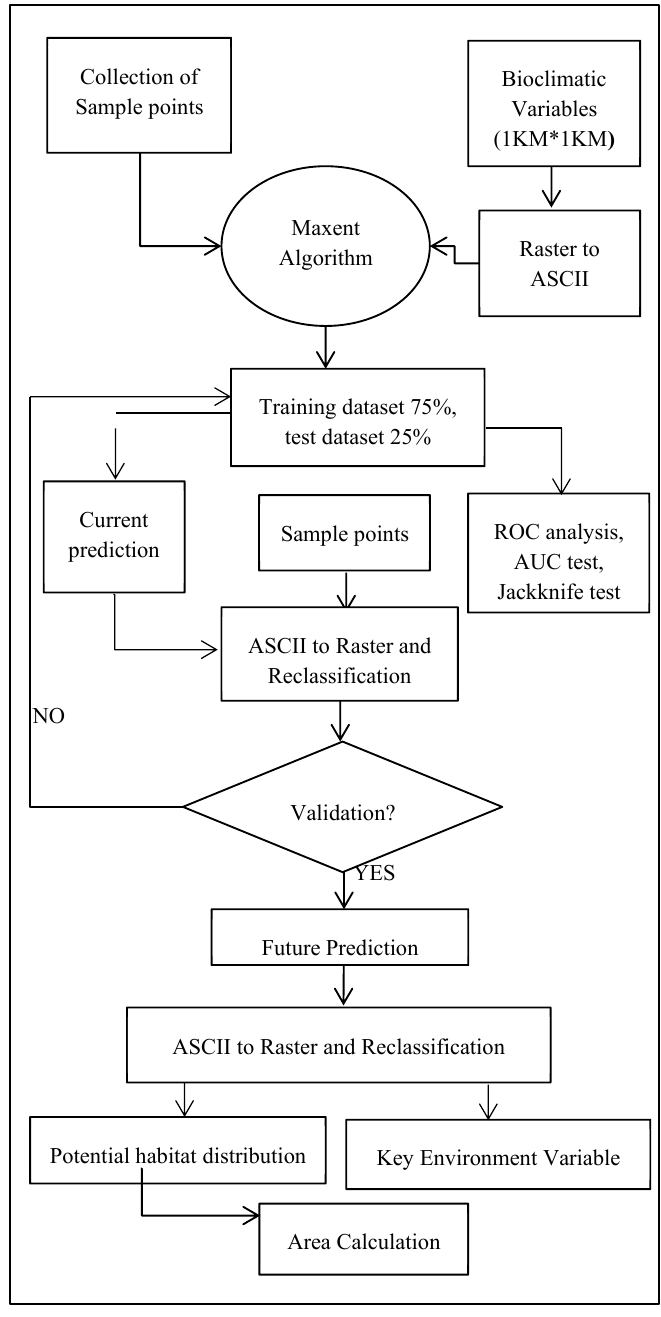
Figure 2. Methodological Flowchart of Potential Habitat Distribution of water